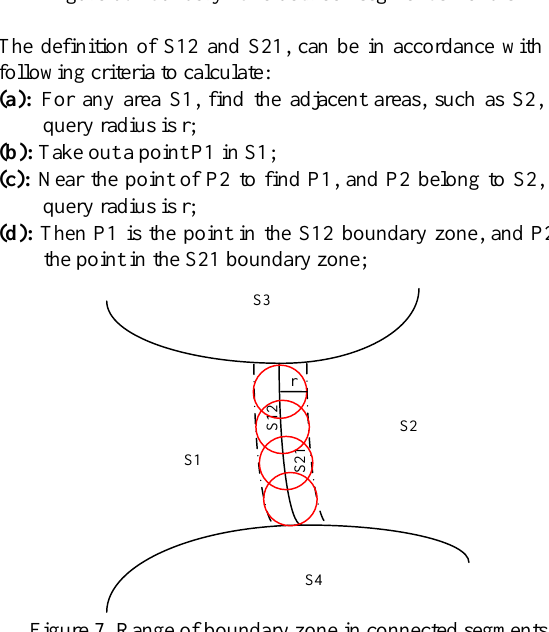
Figure 6. Boundary zone between segment S1 and S2